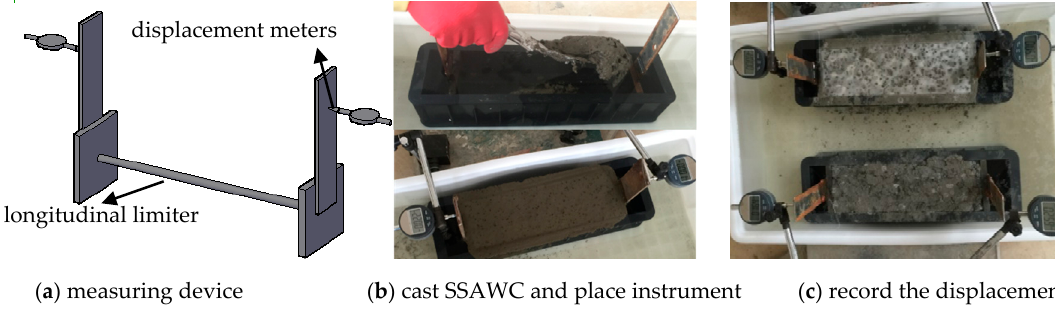
Figure 6. Test of expansive.